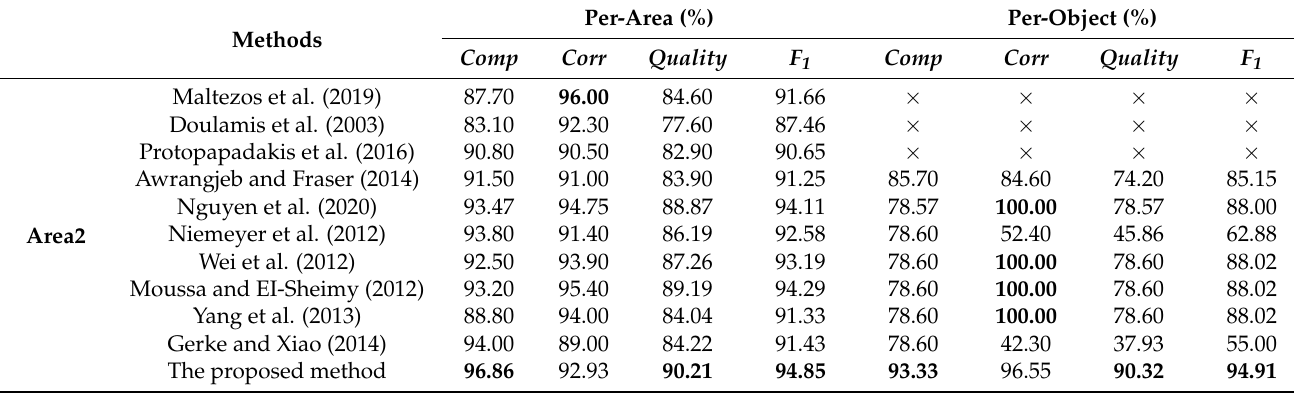
Table 2. Accuracy comparison of building extraction in Area2. The experimental results of the ten methods are obtained from the corresponding references. Bold font represents the highest value among the comparison results. “ × ” denotes that the results are not provided by the reference. Note that the methods proposed by Maltezos et al. (2019), Doulamis et al. (2003) and Protopapadakis et al. (2016) do not provide the completeness, correctness and quality at per-object